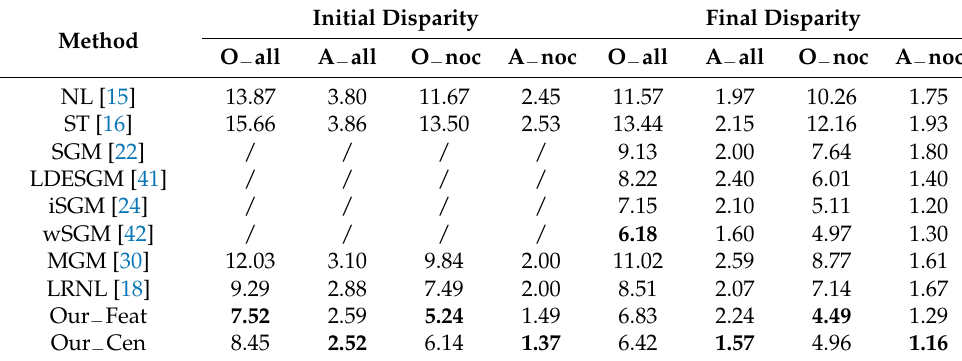
Table 4. Comparison with state-of-the-art cost aggregation approaches on KITTI 2012 dataset [37]. O − all: percentage of erroneous pixels in all region (/%). O − noc: percentage of erroneous pixels in the non-occluded region (/%). A − all: average disparity error in all region (/px). A − noc: average disparity error in the non-occluded region (/px). “/”: the results are not